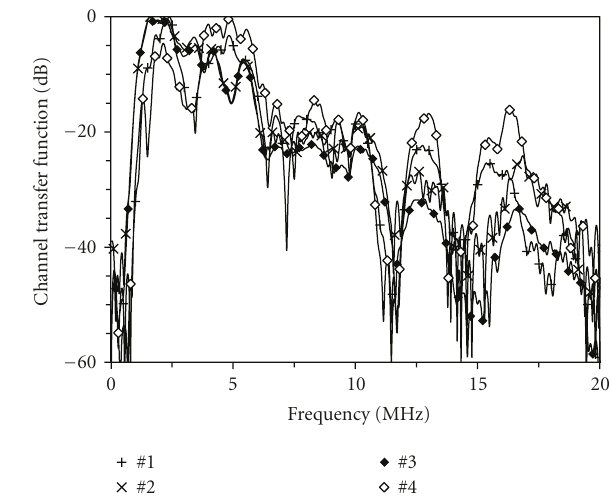
Figure 7: Measured PLC channel transfer